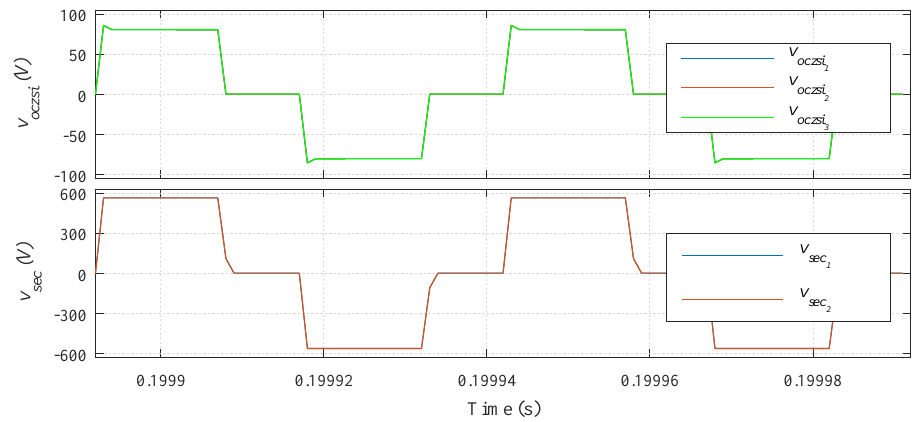
Figure 6. Simulation results: CZSI modules output voltages v oczsi voltages v sec and v sec under balanced conditions. 2 1